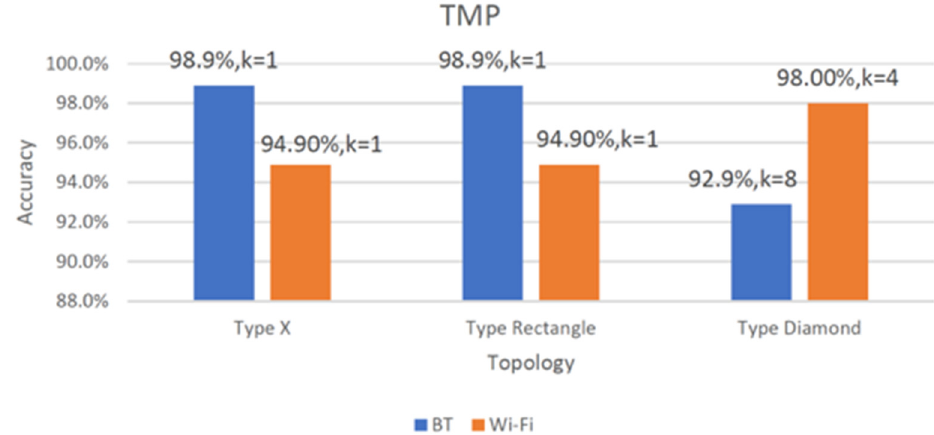
Figure 12. TMP accuracy.